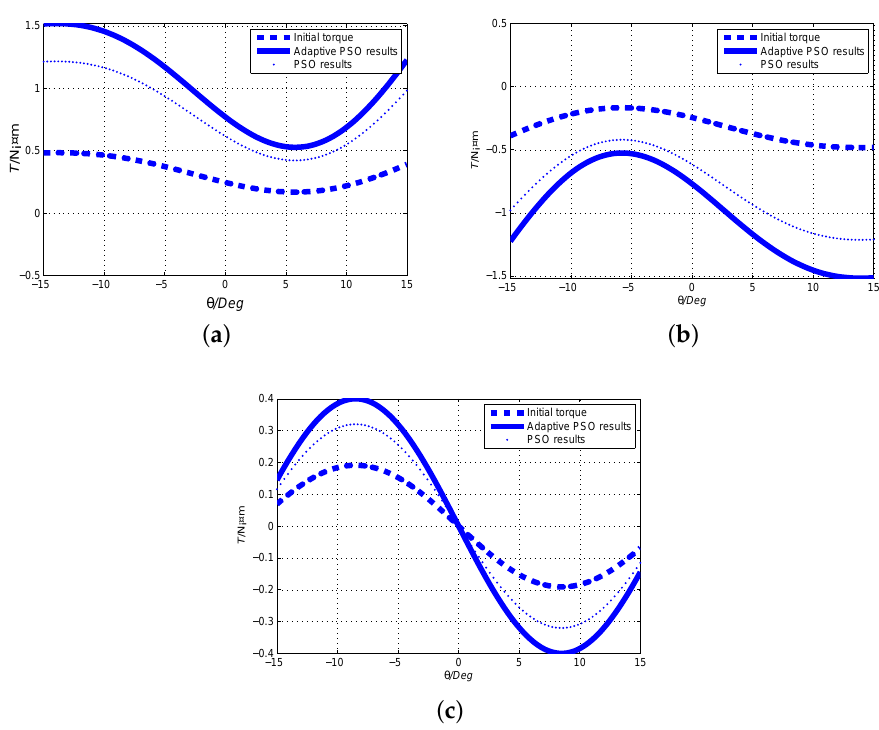
Figure 8. Optimization comparison of output torque. ( a ) Optimization comparison of output torque T o + when current direction is positive; ( b ) Optimization comparison of output torque T o − when current direction is negative; ( c ) Optimization comparison of output torque T f